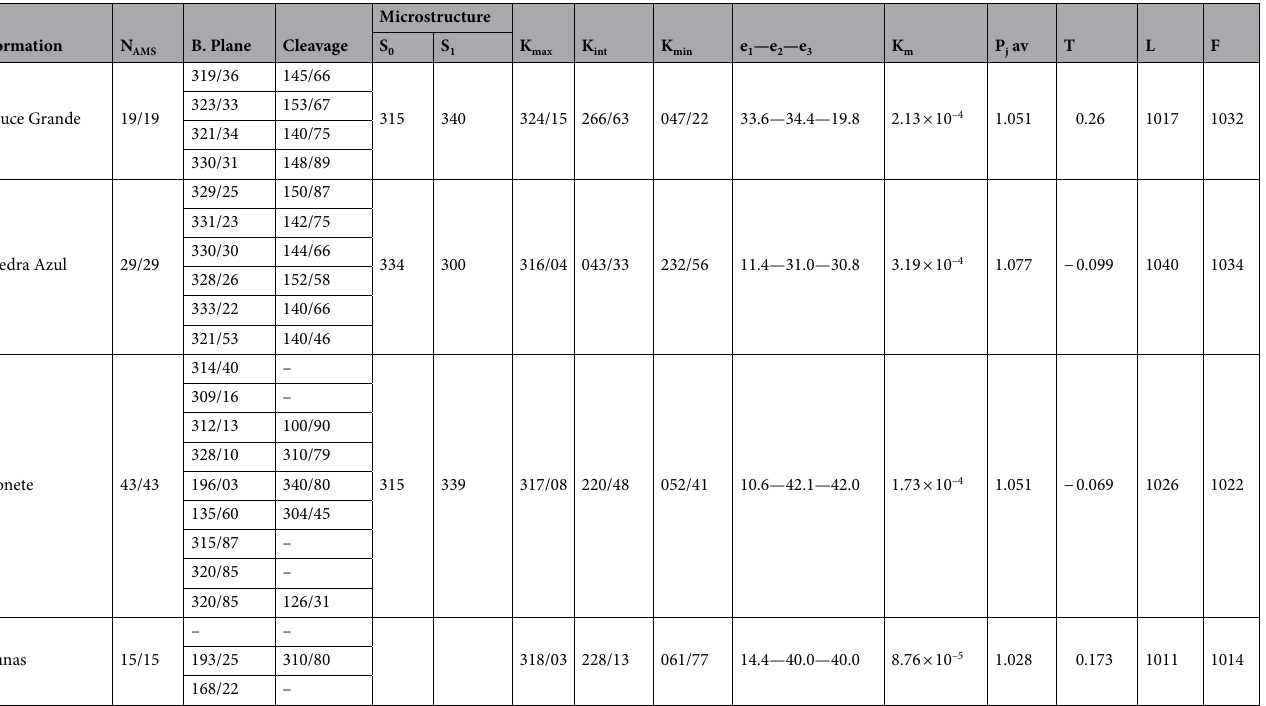
Table 1. Outcrop data for each formation of the Arroyo Atravesado locality of 103 specimens and its anisotropy of magnetic susceptibility parameters. N AMS : number of data (all data were accepted in the analysis). B. Plane: bedding strike (0°–360°) and dip (90° clockwise, from given strike, 0–90°). Cleavage: direction (0°–360°) and dip (90° clockwise, from given strike, 0°-90°). S 0 and S 1 foliations measured in thin Sects. (0°-360°). K max - K int- K min average orientation of the AMS axes and its confidence ellipses e 1 , e 2 and e 3 61 , K m = (K max + K int + K min )/3: average susceptibility volume in SI units; P j av: average anisotropy degree (P = K max / K min : anisotropy degree according to Nagata 62 ; T: average shape parameter of Jelinek 61 ; L = K max /K int : Average lineation; F = K int /K min : Average foliation (Flinn 63 ). See also figure